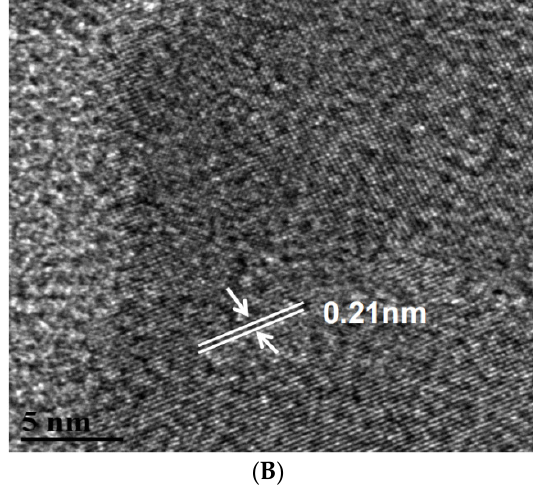
6 of 13 Figure 1. ( A ) Transmission electron microscopy (TEM) image, ( B ) UV-Vis absorption spectrum and fluorescence spec- trum, and ( C ) Fourier transform infrared spectrum (FTIR) of carbon dots (CDs). 3.3. Characterization of BPQDs